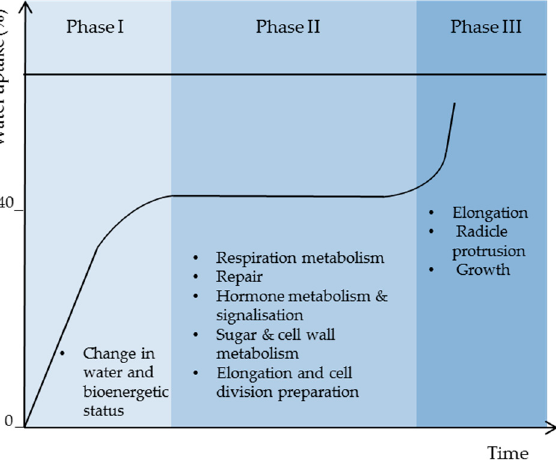
Figure 2. Seed imbibition curve showing the three characteristic phases with their main biological processes. cal